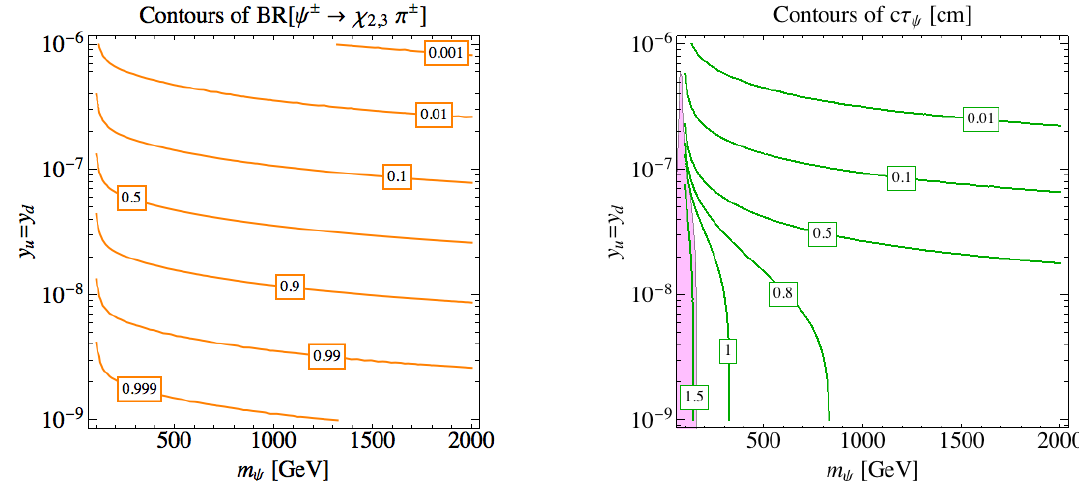
Figure 2 . Left: branching ratios of the decay of the charged fermion into (cid:31) decay length (in cm) of the charged fermion; the shaded region is excluded by the ATLAS search for disappearing tracks [57, 58]. The mass of the lightest neutral fermion is (cid:12)xed to m (cid:31)